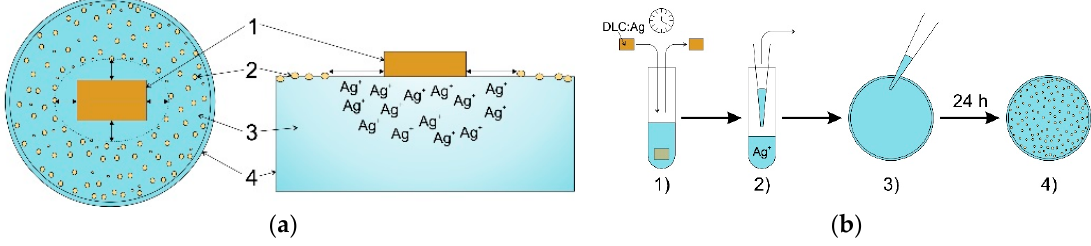
Figure 8. Antimicrobial testing techniques. ( a ) Schematics of the disk diffusion method used for microbiological testing (Ag + diffusion of silver ions from the DLC:Ag surface into agar): ( 1 ) sample coated with DLC:Ag nanocomposite; ( 2 ) bacteria colonies; ( 3 ) agar (bacteria nutrition media); ( 4 ) Petri dish; ( b ) Schematics of the spread plate technique: ( 1 ) bandage prototype soaked in a test tube with bacteria saline solution for different time durations; ( 2 ) the bacterial solution with Ag + ions (0.1 mL) was transported into a Petri dish; ( 3 ) inoculation of bacteria onto the agar surface; ( 4 ) calculation of colony forming units (CFU).